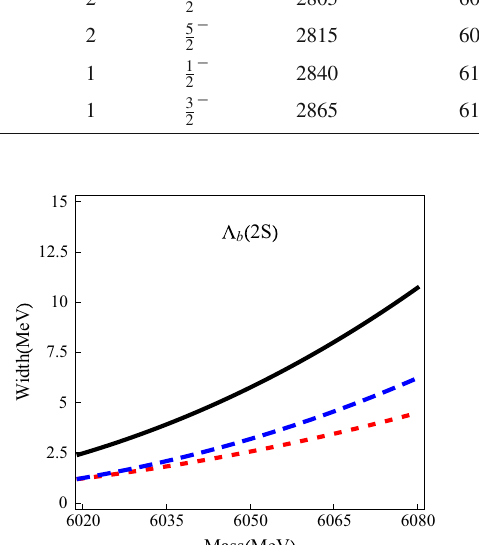
Fig. 1 The decay behaviors for (cid:2) b ( 2 S ) state versus its initial mass. The black line corresponds to the total decay width. The red dotted and blue dashed lines stand for the partial decay widths of (cid:4) b π and (cid:4) ∗ respectively